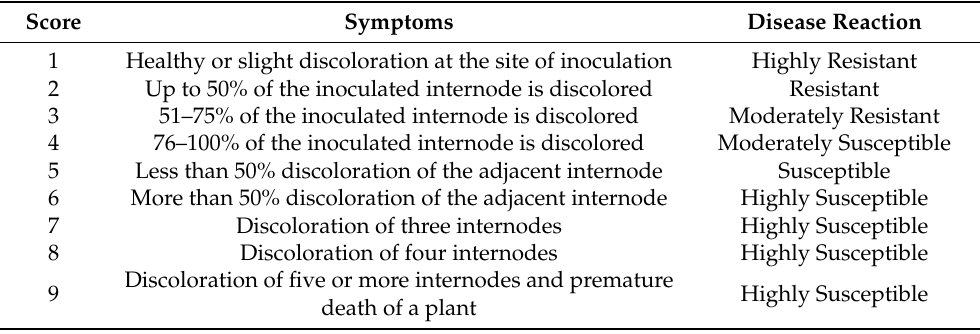
Table 2. Disease rating scale for Fusarium stalk rot: